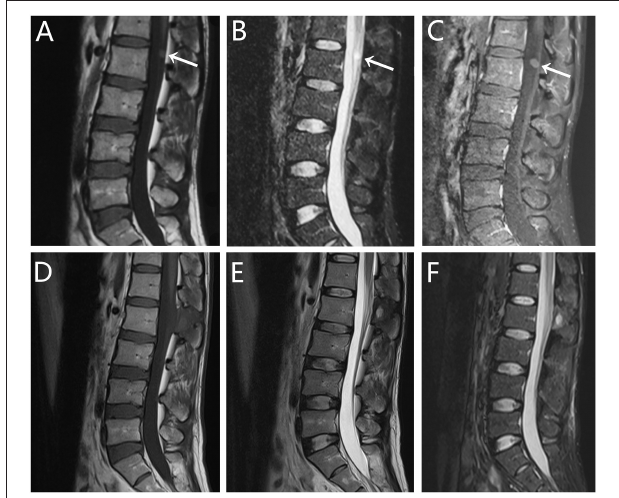
FIGURE 1 | Radiographic images of case 1. (A–C) Pre- and (D–F) postoperative magnetic resonance imaging (MRI) scans revealed a cystic lesion dorsal to the L2 spinal cord. Sagittal MRI scan demonstrated isointense signal on (A) T1-weighted imaging (T1WI) and hyperintense signal on (B) T2-weighted imaging (T2WI). (C) T1WI with gadolinium administration showed slightly enhanced. After 11 months of follow-up, the re-examination MRI showed that the lesion was totally resected, with no evidence of recurrence.